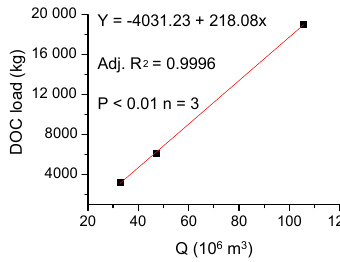
Figure 9. Relationship between annual discharge ( Q ) and DOC load for the three